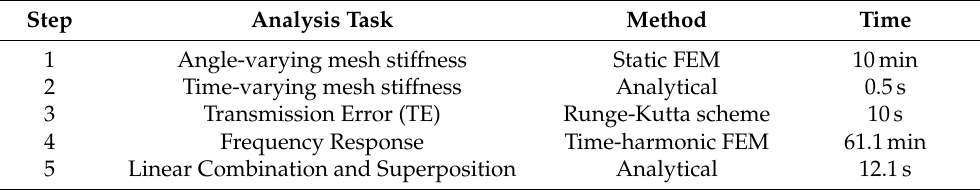
Table 1. Computational time required for each step of the integrated procedure for an application to a 2.5MW wind turbine gearbox.